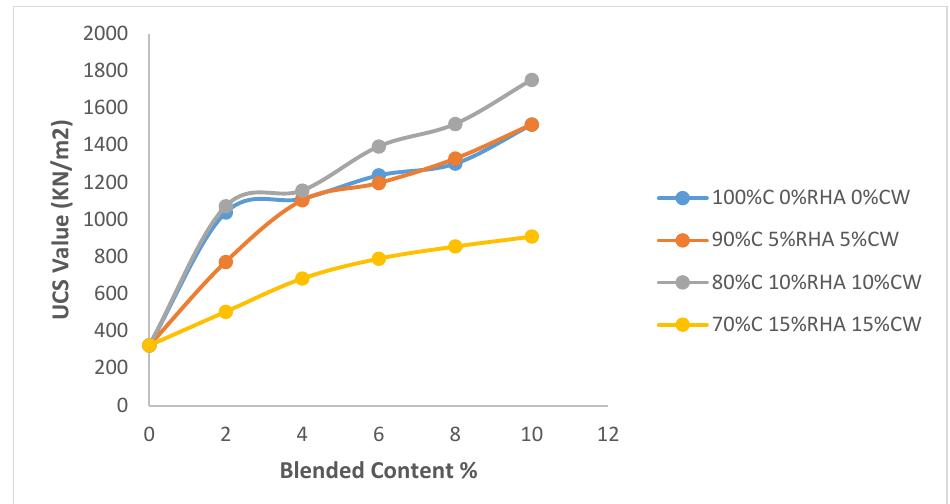
Fig. 11. Relationship between the 14days UCS values of laterite treated with (100%C 0%RHA 0%CW), ( 90%C 5%RHA 5%CW),(80%C 10%RHA 10%CW)& (70%C 15%RHA 15%CW) blend of